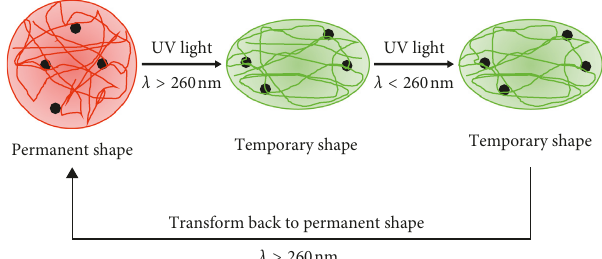
Figure 5: Schematic diagram of the molecular mechanism of photoresponsive